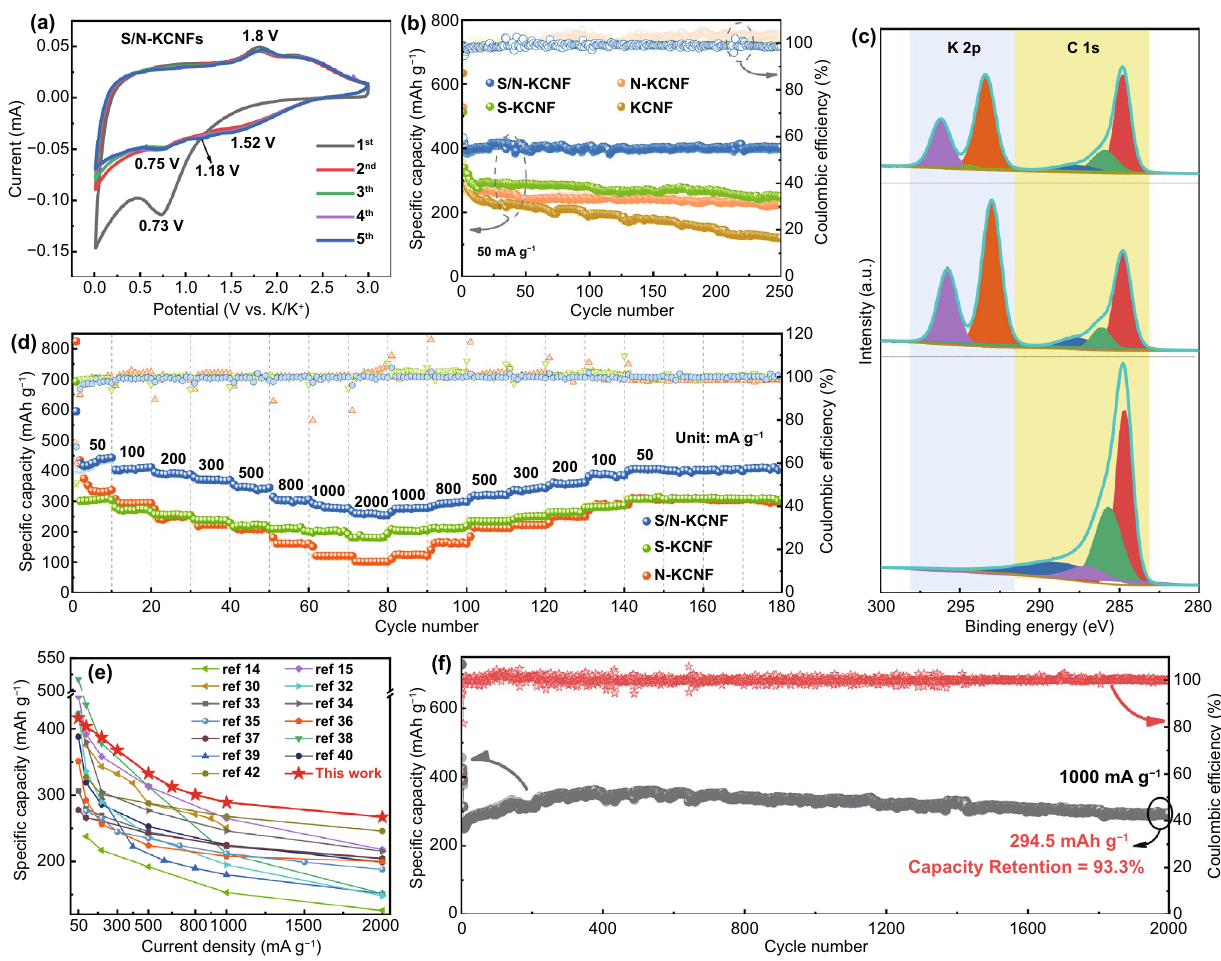
Fig. 6 a The first five CV cycles of S/N-KCNFs; b the specific capacity cycling test and coulomb efficiency were carried out at current density of 50 mA g −1 , when S/N-KCNFs, S-KCNFs, N-KCNFs and CNFs are used as anodes of PIBs; c the ex situ XPS of S/N-KCNFs as anode of PIBs during discharge and charging; d the rate capability of S/N-KCNFs, S-KCNFs and N-KCNFs at 50–2000 mA g −1 current density; e com- parison of the rate performance of different carbonaceous materials in PIBs with our current work; f the steady cycle performance and coulomb efficiency of S/N-KCNFs under high current density of 1000 mA g −1 for 2000 ultra-long cycles were